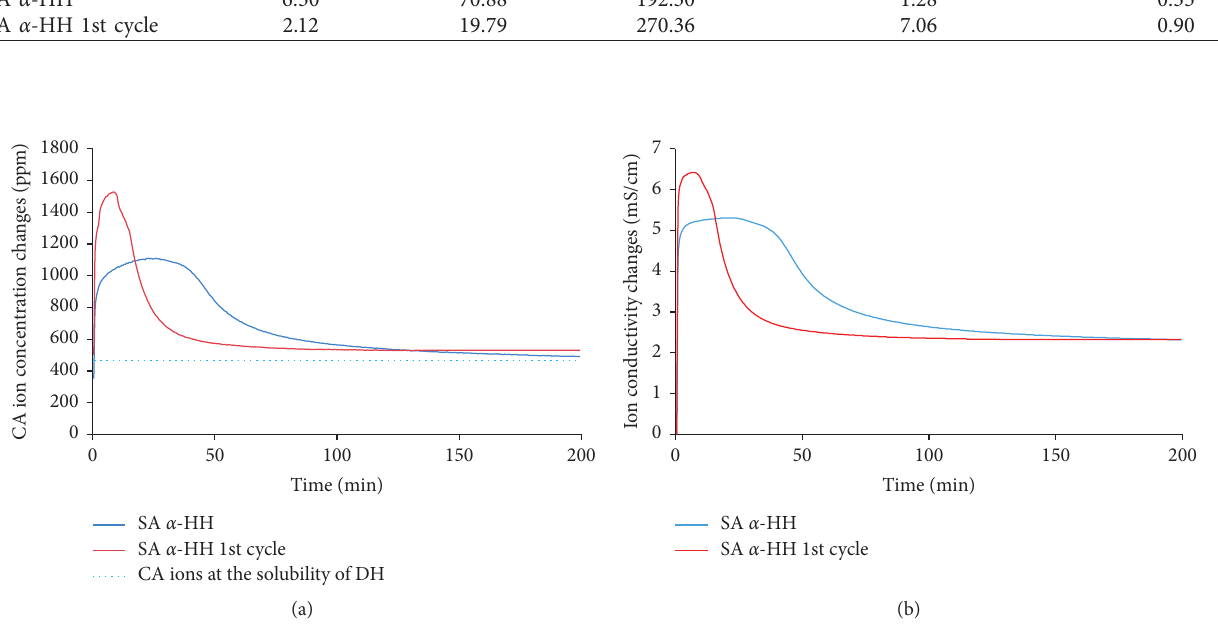
Figure 8: Ca 2+ -Ion concentration and ion conductivity changes for pure SA α -HH and SA α -HH after the first cycle: (a) ion concentration changes and (b) ion conductivity